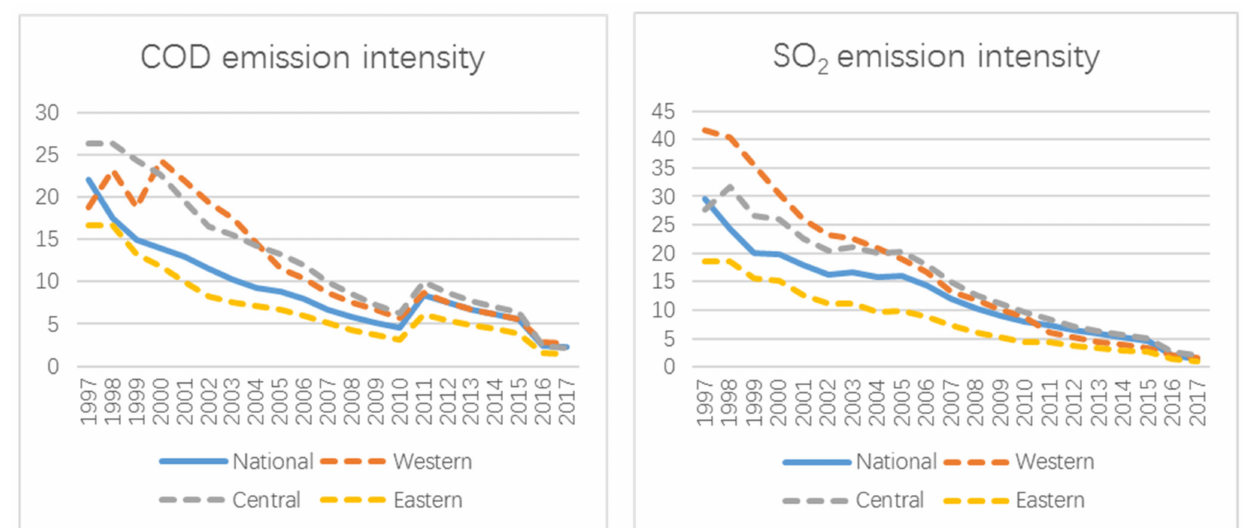
Figure 4. Pollutant emission intensities in different